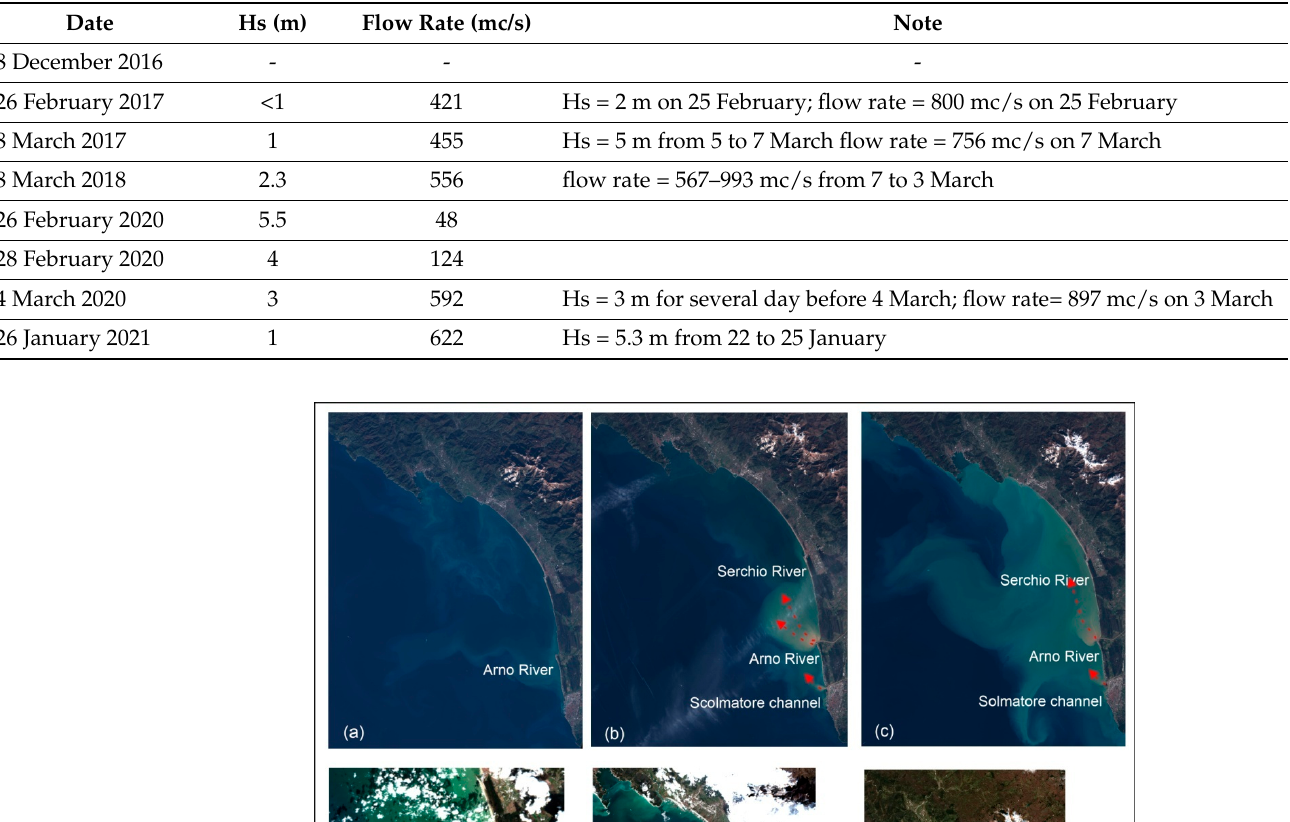
Table 1. Significant wave height and flow rate values for both studied and storm surge events visible from the available Sentinel 2 images are shown. The symbol “–” indicates the lack of a storm surge event.